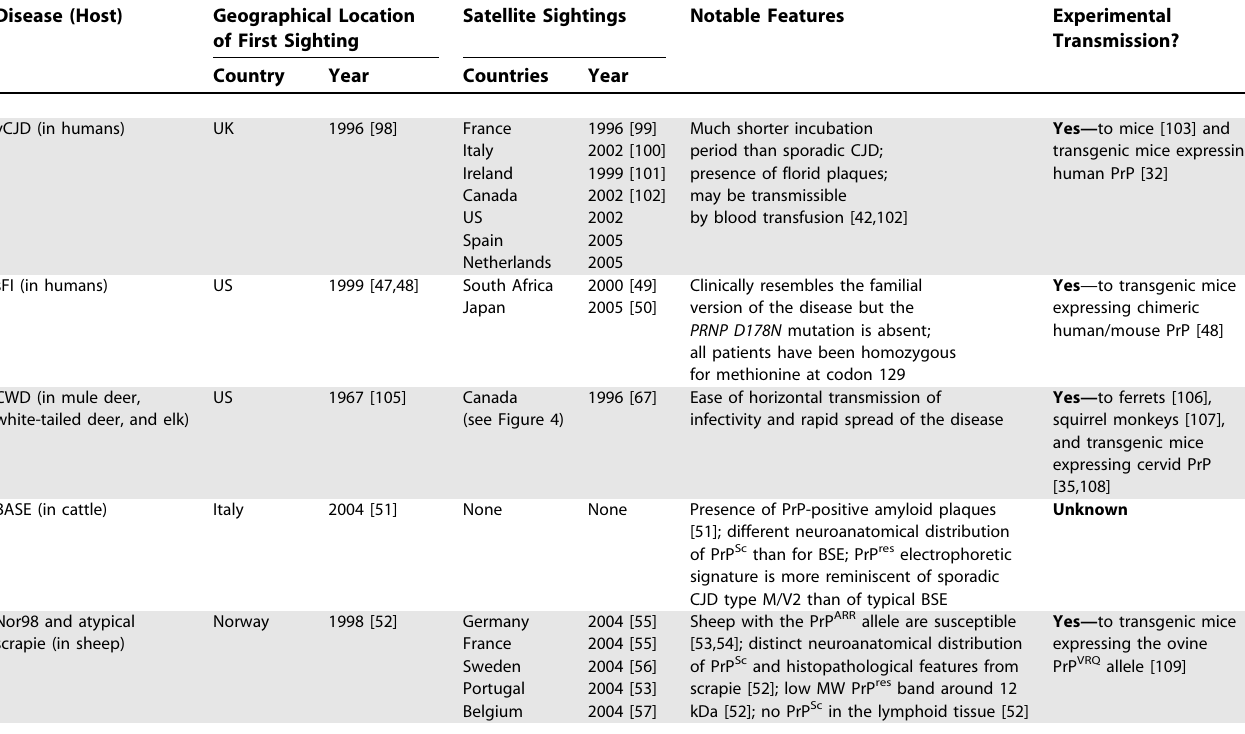
Table 2. Emerging Prion Diseases in Animals and in Humans Disease (Host) Geographical Location of First